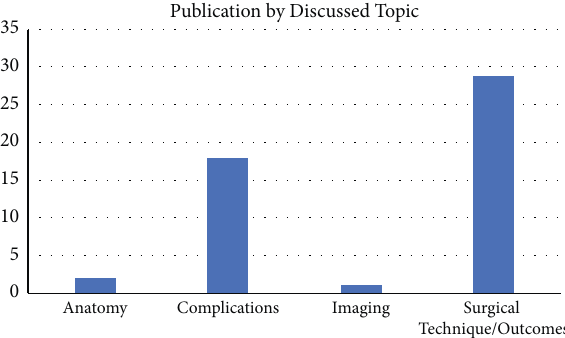
Figure 8: Publication by topic